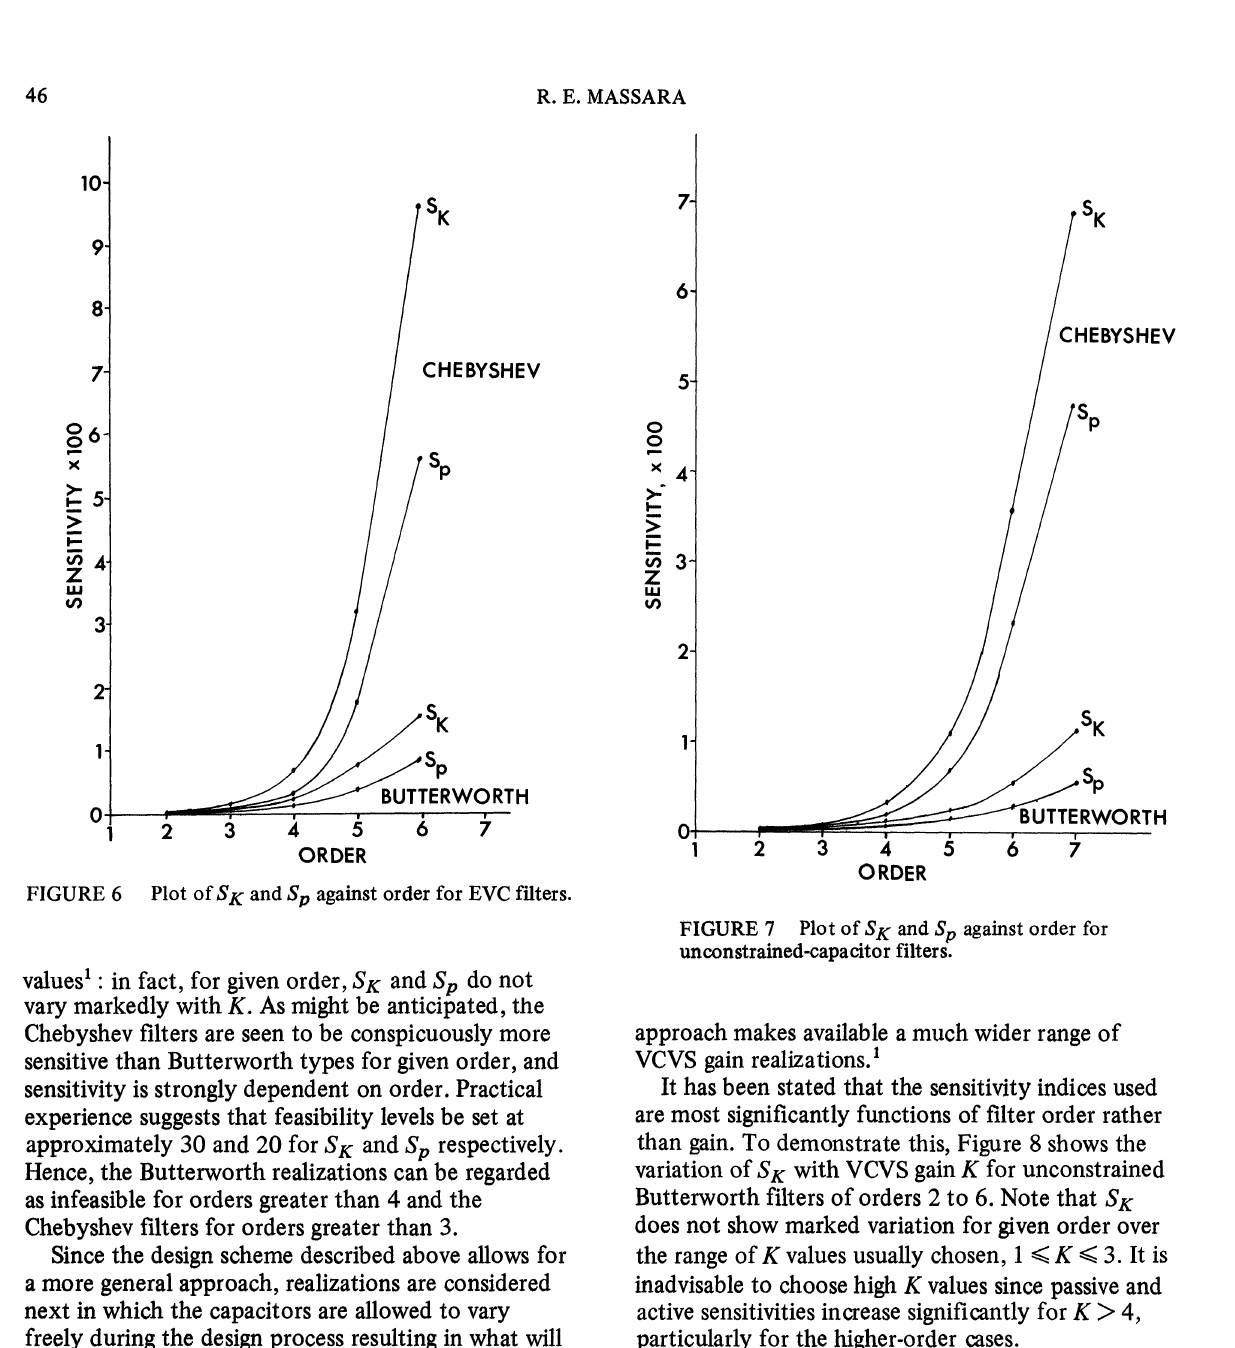
S K Sp BUTTERWORTH o 2 3 4 ORDER FIGURE 6 Plot of S K and Sp against order for EVC filters.